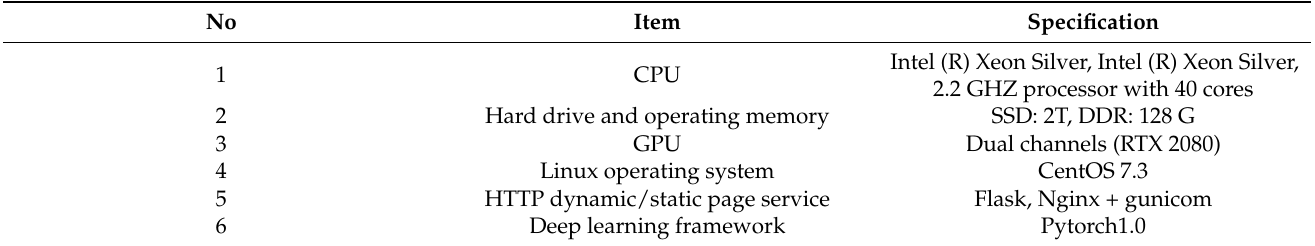
Table 1. Configuration of the EyeBirds